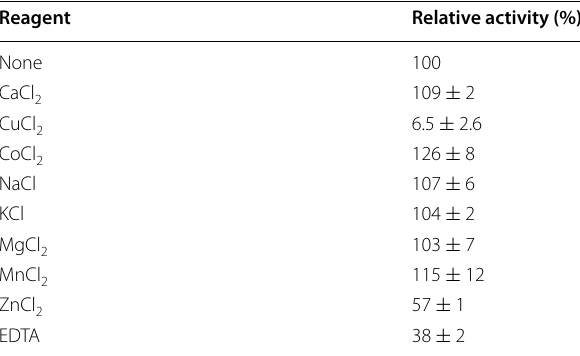
Table 1 Effect of various metal ions and chemical